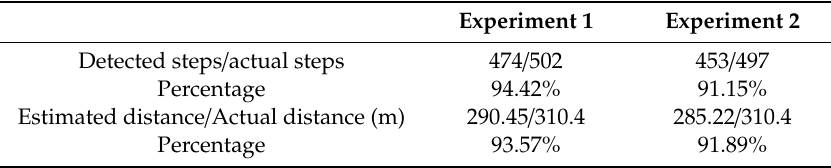
Table 2. Step detection and traveled distance estimation